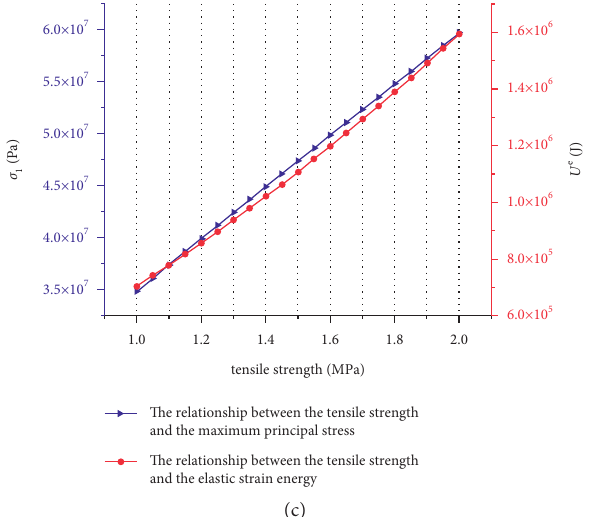
e . (a) The relationship between cohesions, σ 1 , and U